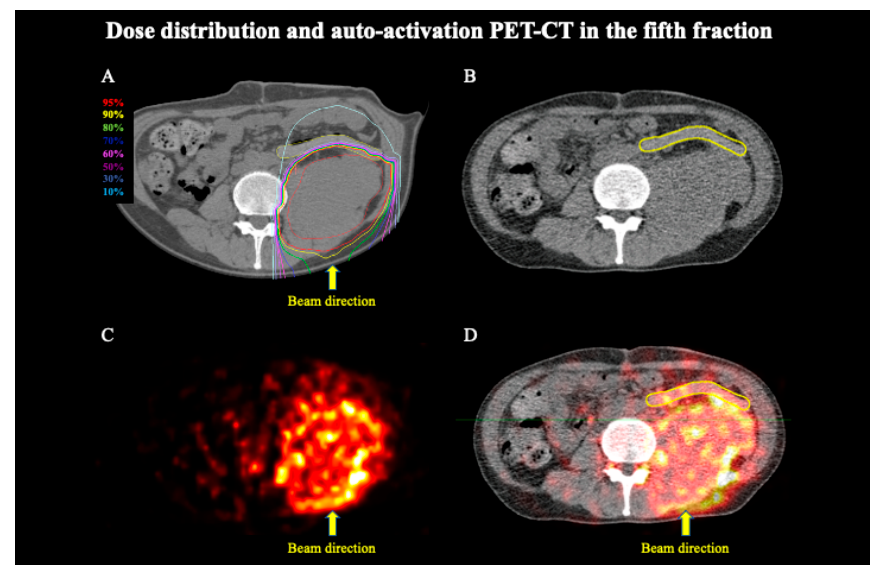
Figure 4. Dose distribution of C-ion RT and AAPET images with a 180° beam in the fifth fraction. ( A ) Dose distribution of C-ion RT with 180° beam. The area within the red outline is the tumor. Highlighted are the 95% (red), 90% (yellow), 80% (green), 70% (deep blue), 60% (magenta), 50% (purple), 30% (blue), and 10% (light blue) isodose curves (100% was 4.4 Gy (RBE)). ( B ) CT image simultaneously taken with the PET scan. The area within the yellow outline is the spacer. ( C ) AAPET image. ( D ) Positron emitter distributions obtained by merged CT and AAPET images. The area within the yellow outline is the spacer.